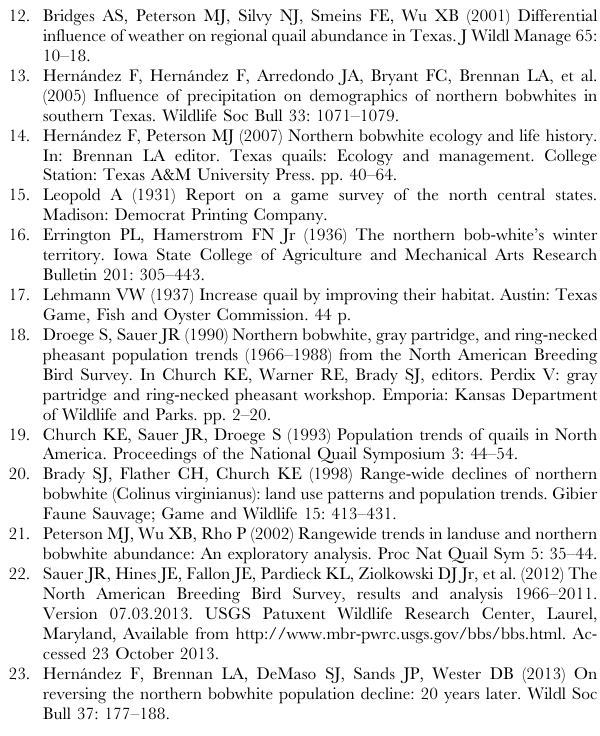
Table S3 NB1.1 Comparative Genome Aligment to Chicken (S3a) and Zebra Finch (S3b). Table S4 Summary of all Repeat Masker Analyses. (ZIP) Table S5 Summary of All PHOBOS Repeat Analyses. (ZIP) Table S6 Summary of Putative Nuclear Annotation Models via GlimmerHMM and Blastx with Manual Annotation of the Mitochondria and a Synopsis of MHC Annotations. Table S7 Galgal4.71 cDNA Refseq Mappings onto NB1.1. (XLSX) Table S8 Galgal 4.71 ab initio (GENSCAN) Transcript Mappings to NB1.1. (XLSX) Table S9 Bobwhite de novo cDNA Contigs-Blastx to all Avian Proteins. (XLSX) Table S10 Bobwhite cDNA Contig Map Positions in NB1.1. (XLSX) Table S11 Bobwhite de novo Outlier Contigs (NB1.0) from Genome-Wide Analyses of Divergence with the Chicken and Zebra Finch Genomes. (XLSX) Table S12 NB1.0 QC Analysis on Conserved Outliers Using Additional (Appended) Non-overlapping Blastn